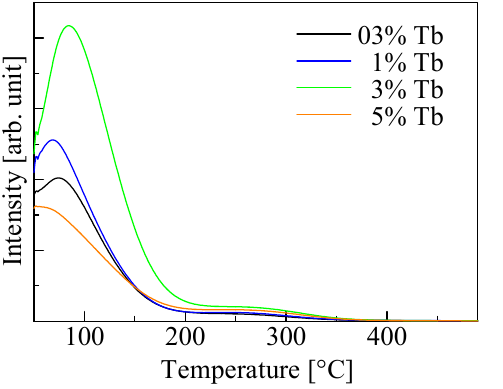
Figure 6. TSL glow curves of Tb-doped MgGa 2 O 4 after X-ray irradiation of 100 mGy.